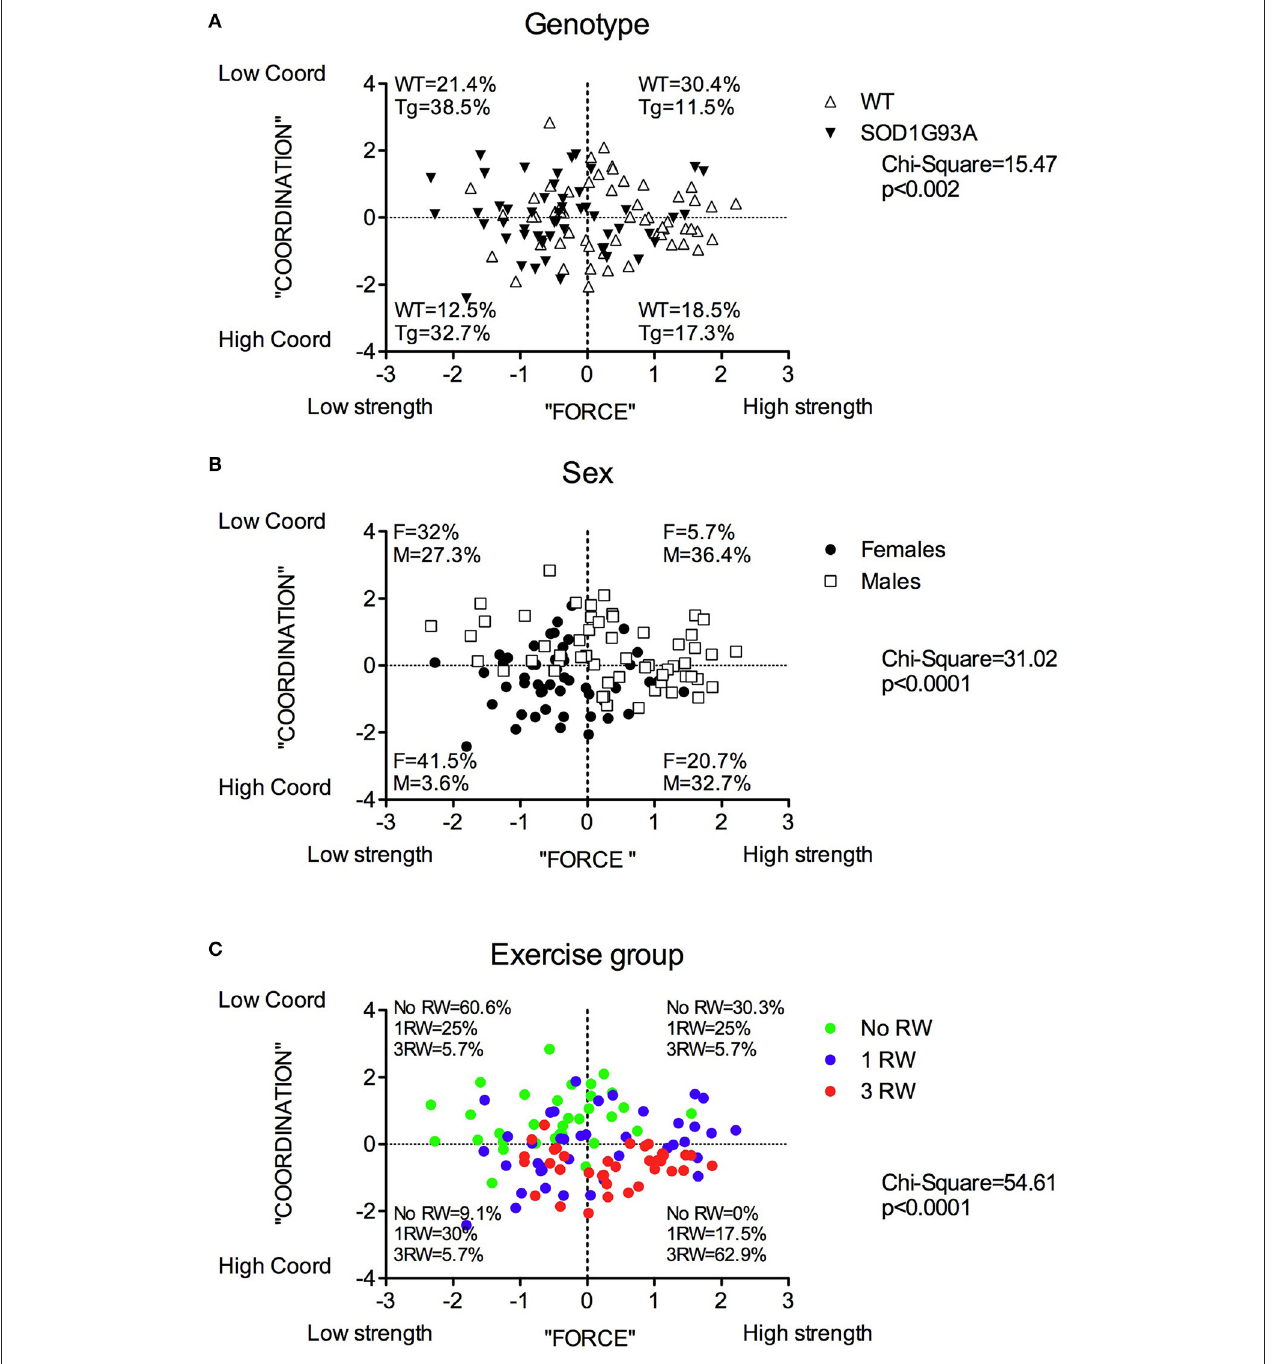
FIGURE 7 | Distribution of mice in the PC1 “Force” and PC2 “Coordination” principal components space for each between subjects factor: Genotype, Sex and Group. Distribution and percentage of individuals of (A) the two genotypes, (B) the two sexes, (C) the three exercise groups in the four quadrants subdividing the “Force”/”Coordination” space. Chi-square values are significant for each